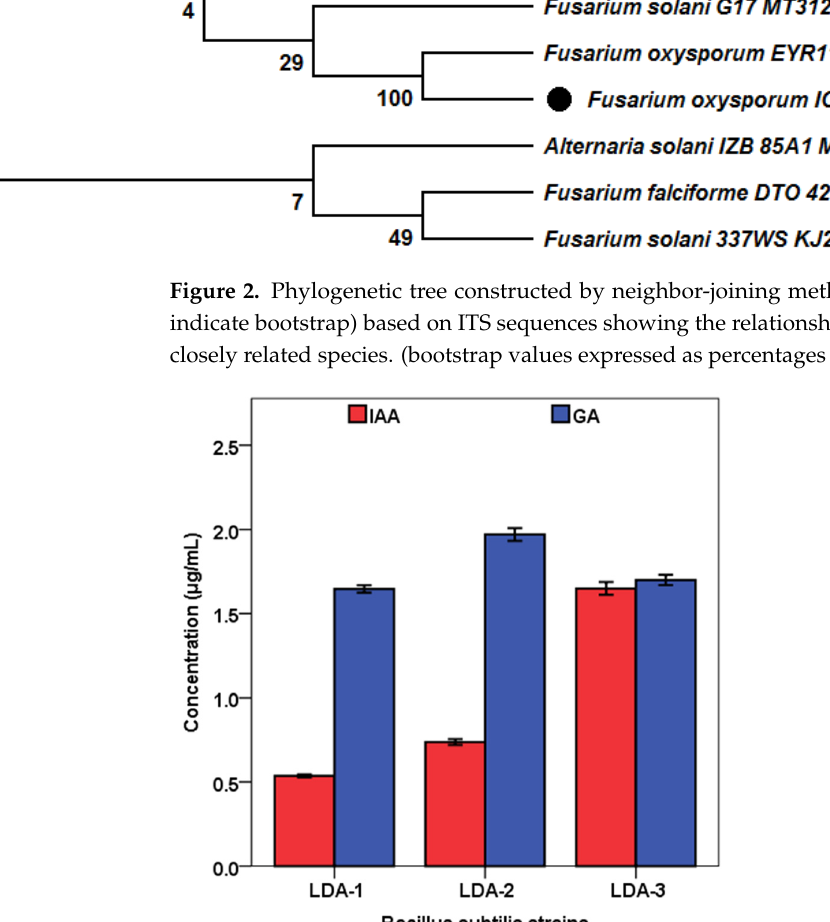
Figure 4. Growth inhibition of phytopathogenic fungi by B. subtilis strains isolated from the rhizo- sphere of P. glandulosa plants, in dual-plate assay. Values = mean ± SE, (n = 3).